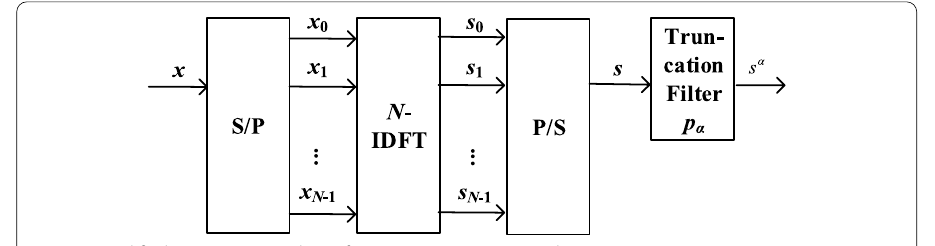
Fig. 1 Simplified generation modem of compressive OFDM